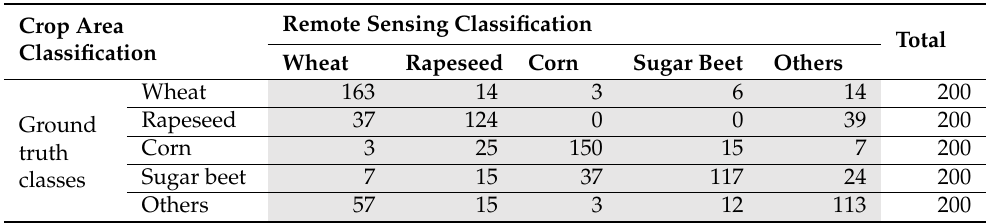
Table 5. Test points classification using G strategy, with 200 pixels selected by simple random sampling from each set of ground class